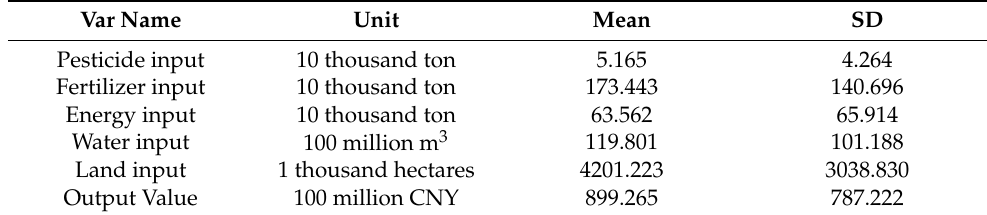
Table 1. Summary statistics of agricultural production input and